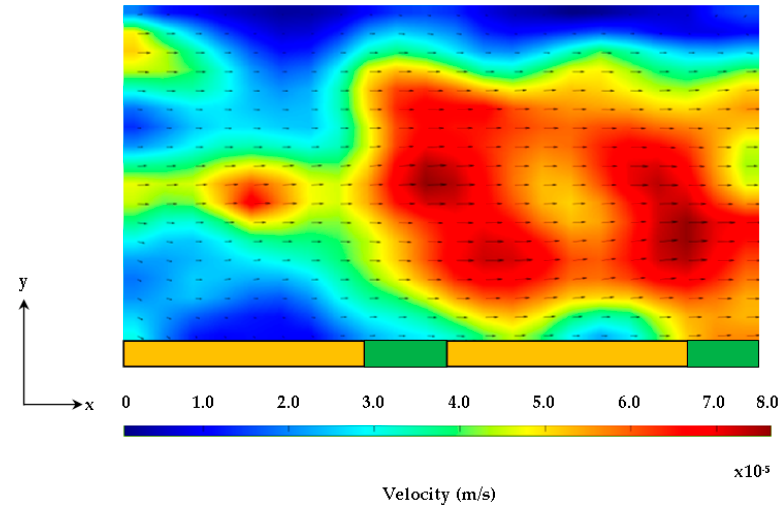
Figure 24. Velocity contour of 10 µm diameter fl uorescent particles at 4 A and 10 Hz.